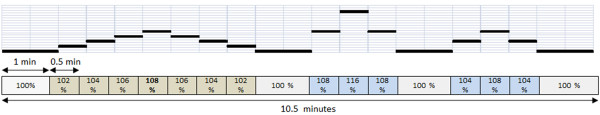
Distortion profiles applied during the trial. The experimental trial lasted 10.5 minutes, starting and ending with one minute of walking without distortion. Each distortion level lasted for 30 seconds. The rate changes in distortion level were 2%, 8%, and 4% in the first, the second, and the third block periods, respectively. The horizontal bars graphically represent the change of distortions over time.